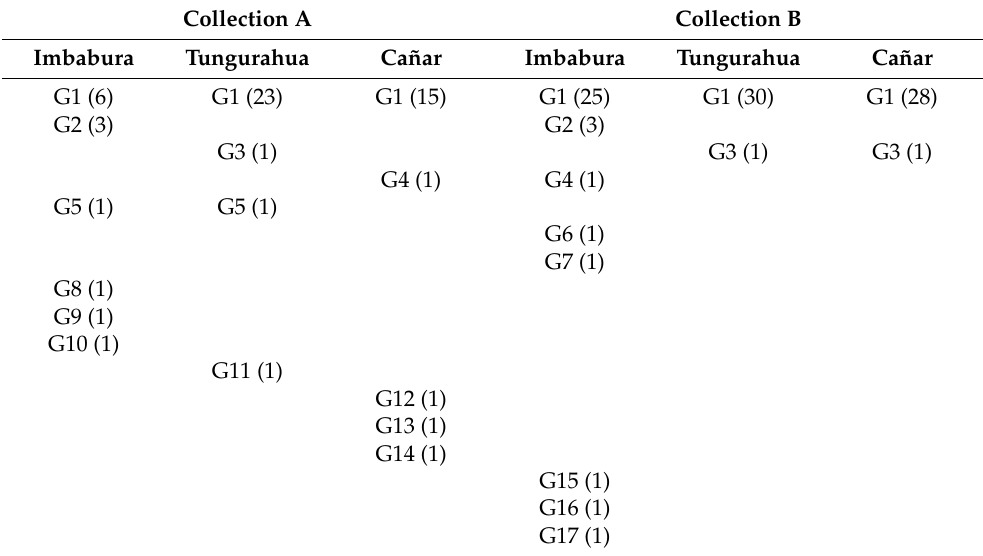
Table 4. Distribution of the 17 genotypes (G1 to G17) found in accessions collected in the provinces of Imbabura, Tungurahua, and Cañar between 1981 and 1986 (Collection A) and 2014 and 2015 (Collection B). The number of samples (of the 152 analyzed) in each province and collection that presented each of the genotypes are indicated in parentheses. Different letters indicate significant